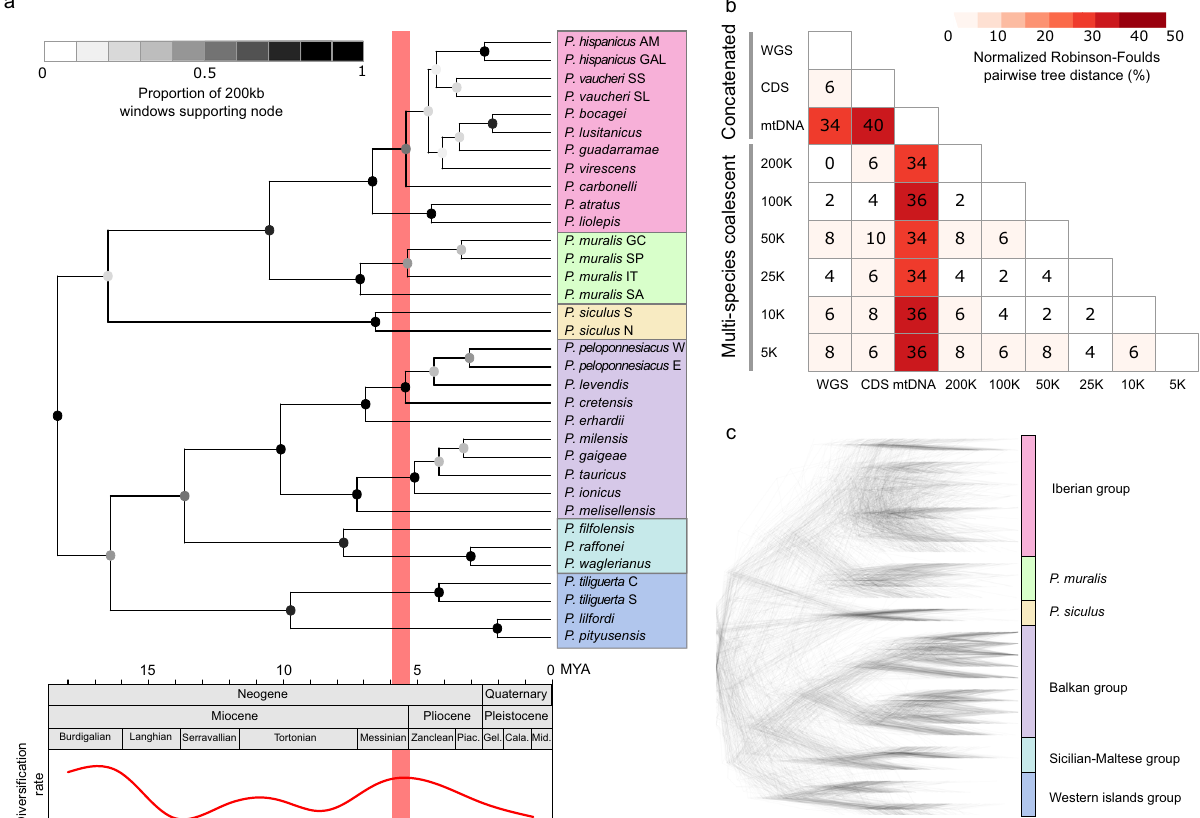
Fig. 2 Phylogeny of Podarcis wall lizards. a The time-calibrated ML phylogenetic tree of the 34 major lineages of wall lizards based on whole-genome sequences (outgroup not shown). All nodes were 100% supported with 1000 bootstrap replicates, but not across all local trees (grey-scale of nodes signi fi es proportion of local trees derived from 200 kb windows in support of a given node). The lower panel shows the geological time scale of the evolutionary history of Podarcis and the estimated diversi fi cation rate. The thick red line indicates the Messinian Salinity Crisis (~6.0 – 5.3 MYA). The coloured rectangles on the tips of the tree denote geographically coherent groups of wall lizards. b A summary of the similarities, given as normalized Robinson – Foulds distances, between all phylogenies reported in this study (phylogenies are shown in Supplementary Fig. 5 and Supplementary Figs. 8 – 10). See Supplementary Table 2 for a summary of approaches and datasets. c A ‘ DensiTree ’ illustration of the prevalent discordances among 500 randomly selected local trees derived from 200 kb windows (with branch length proportional to genetic change). Abbreviations: Cala. Calabrian, Gel. Gelasian, Mid. Middle, Piac.